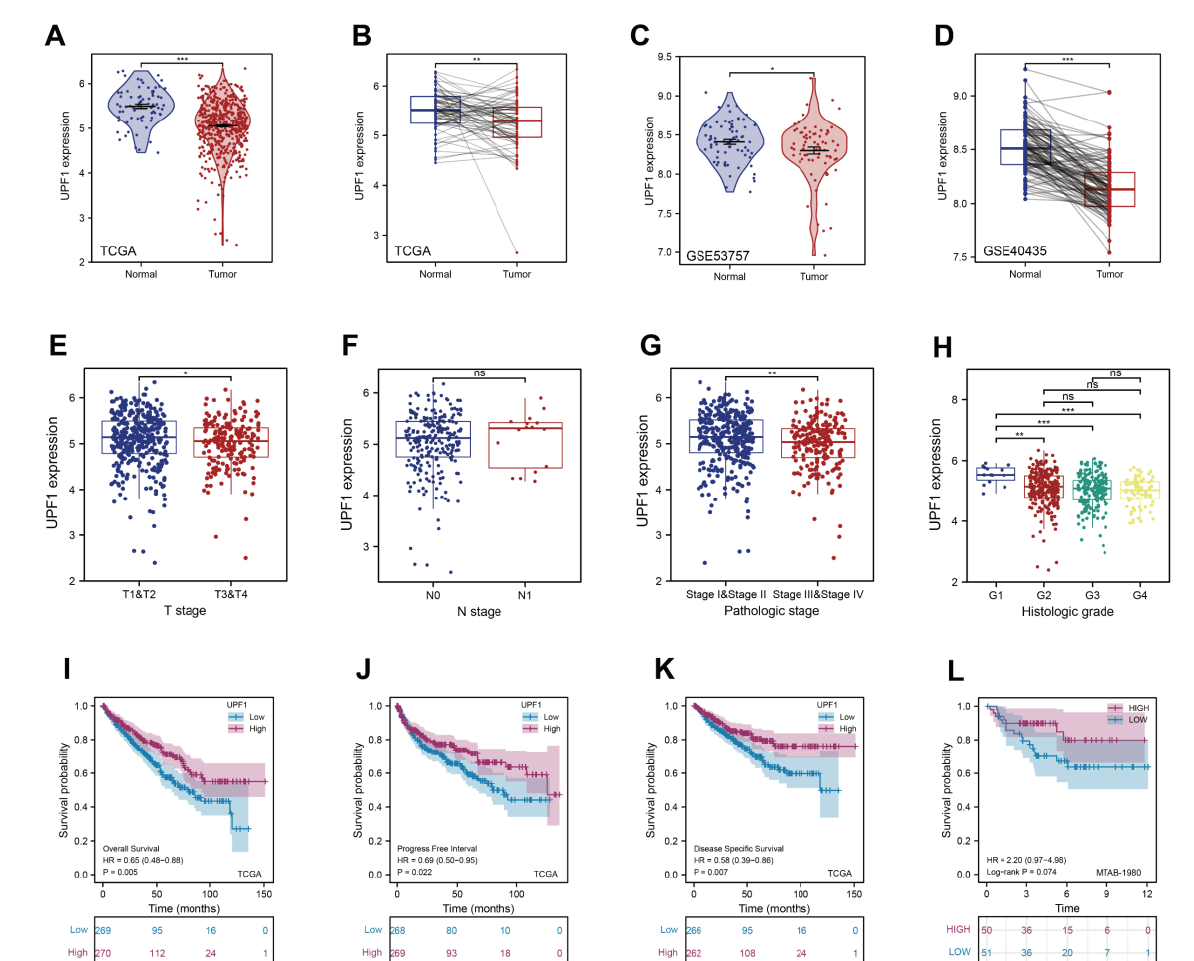
Figure 2. Characteristics of UPF1 expression status in ccRCC tissue samples from databases. ( A ) The expression of UPF1 based on TCGA data. ( B ) TCGA data (paired samples) showing UPF1 expression. ( C ) GEO-based expression of UPF1 (GSE53757). ( D ) GEO-based expression of UPF1 (GSE40435). ( E ) Relationship between UPF1 expression and T stage. ( F ) The relationship between UPF1 expression and Lymph node metastasis. ( G ) The relationship between UPF1 expression and Pathological stage. ( H ) The relationship between UPF1 expression and Histologic grade. The effect of UPF1 expression on ccRCC patients’ overall survival ( I ), progression-free survival ( J ) and disease-specific survival ( K ) based on the TCGA. ( L ) The effect of UPF1 expression on ccRCC patients’ overall survival based on the MTAB-1980 cohort. * p < 0.05, ** p < 0.01 and *** p < 0.001. ns: no